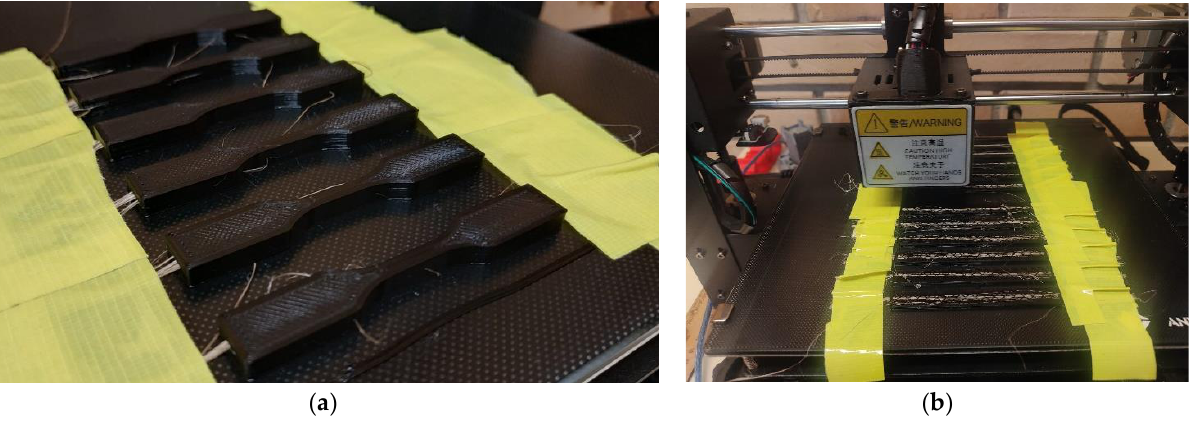
Figure 3. PLA printed specimens for tensile ( a ) and bending tests ( b ).